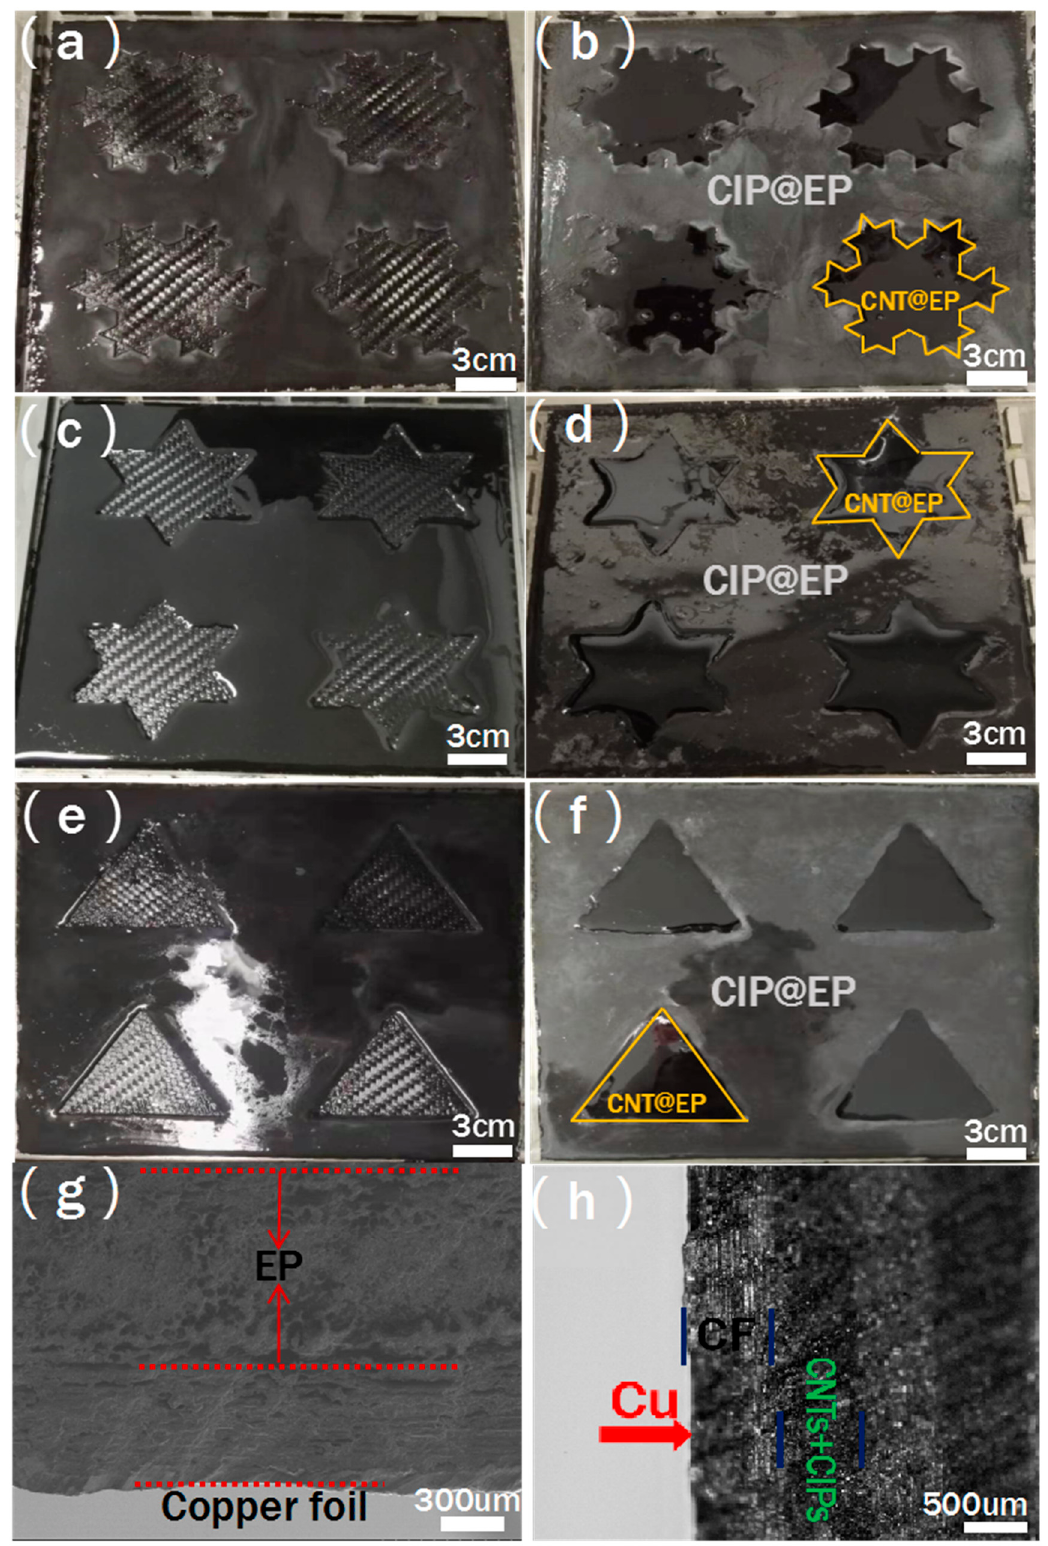
Figure 2. Pictures of absorbing layer (AL) in the samples with n = 2 ( a , b ); n = 1 ( c , d ); n = 0 ( e , f ); SEM ( g ); and optical ( h ) microscopes of the cross section for the sample with n = 2. As is well known, filler distribution and the interface between fillers and the matrix in composite materials are two key factors for obtaining their good performance [21]. Therefore, in order to